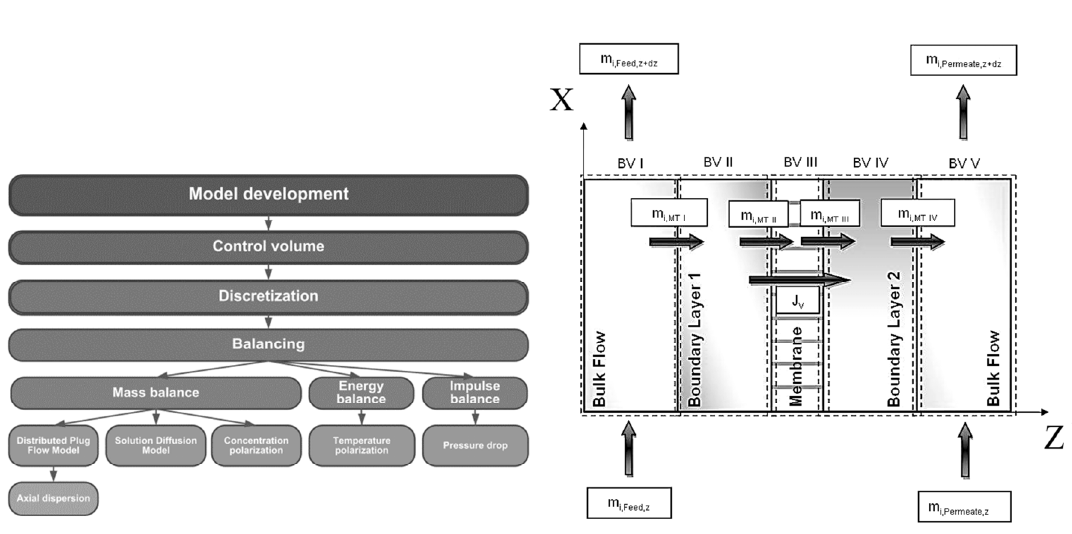
Figure 4. Left : Course of action used for the pervaporation model development. Right : Overview of the five control volumes used in modelling and simulation. Adapted from [23].